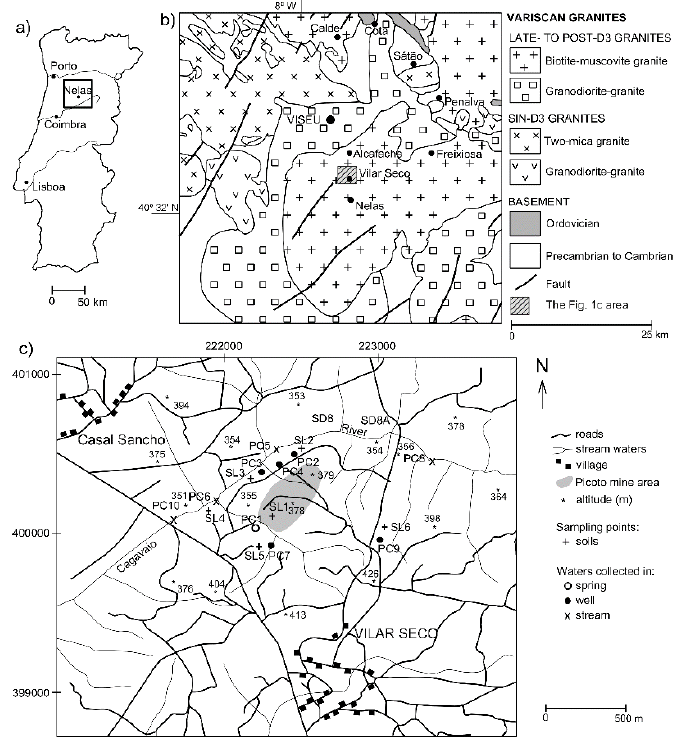
Figure 1. Study area: ( a ) geographical setting; ( b ) geological map; ( c ) location of the soil and water sampling